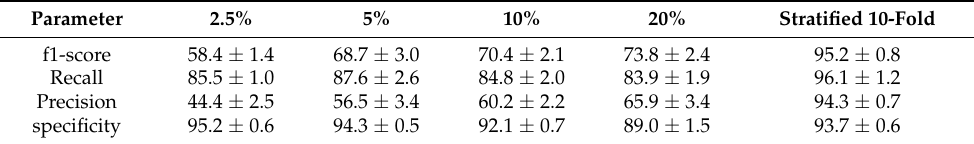
Table 5. Results (mean ± standard deviation %) of the imbalanced nested cross-validation at four different prevalence rates and stratified nested 10-fold cross-validation using only the time, frequency, and MFCC